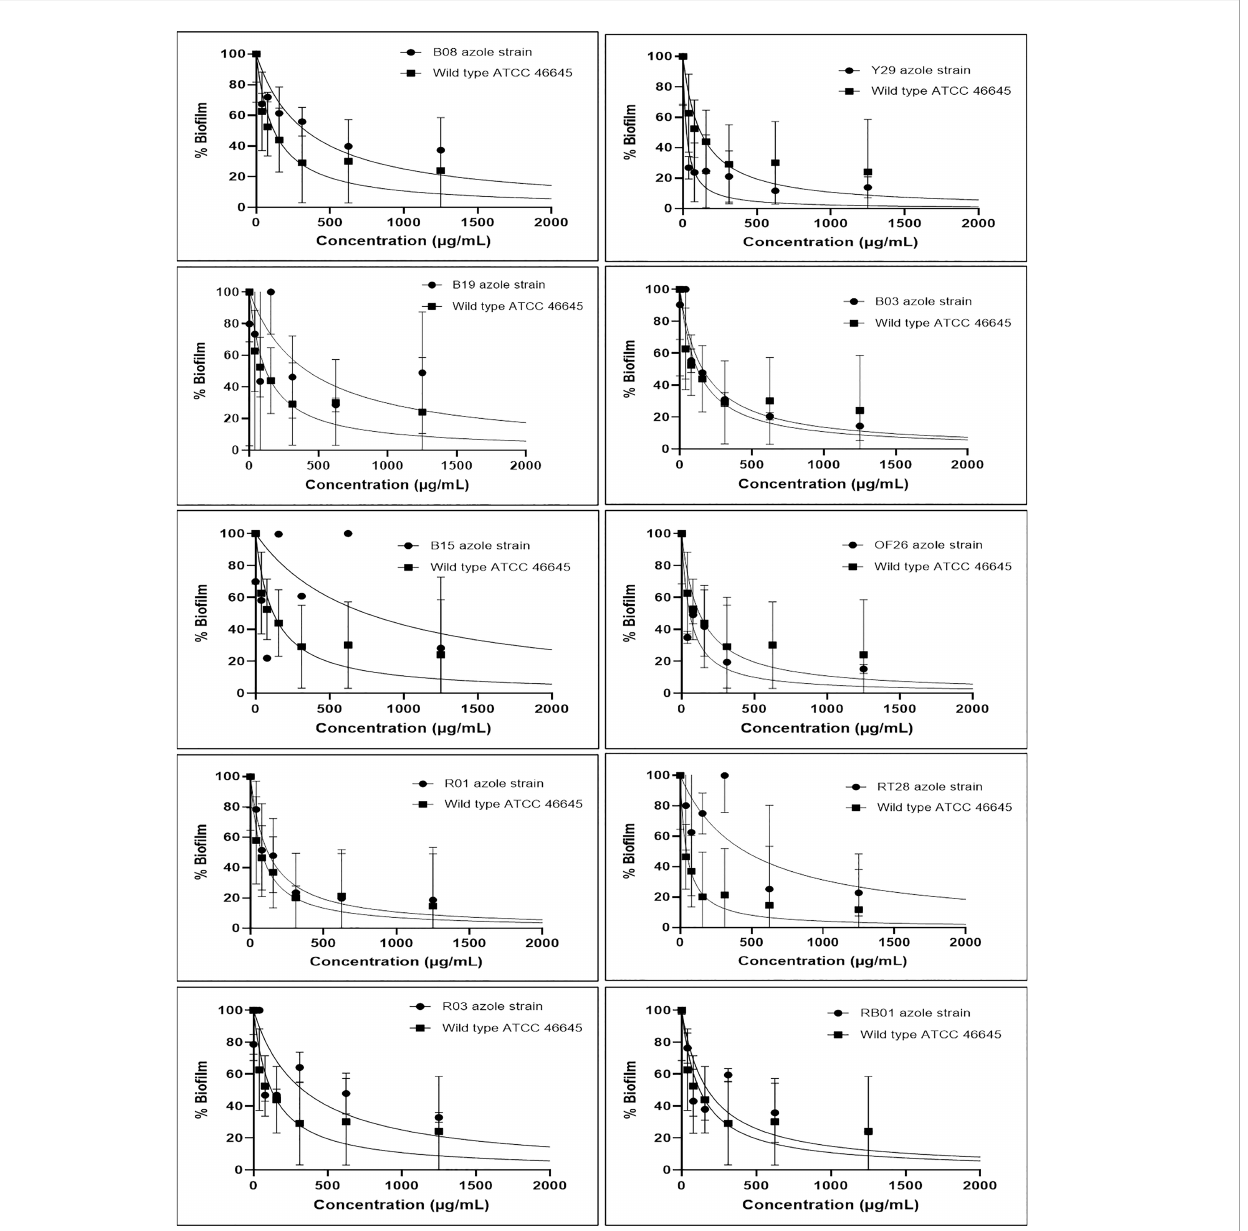
FIGURE 1 Effect of eugenol on bio fi lm percentage in azole resistant (B08, Y29, B19, B03, B15, OF26, R01, RT28, R03 and RB01) isolates and susceptible (wild-type ATCC 46645). BEC 80 of eugenol ranged from 312 – 500 µg/mL except B19, B15, and RT28 isolates having BEC 80 of >1000 µg/mL. Experiment was carried out in duplicate and analysed for statistical signi fi cance using non-linear regression in a dose response manner with 95% con fi dence interval